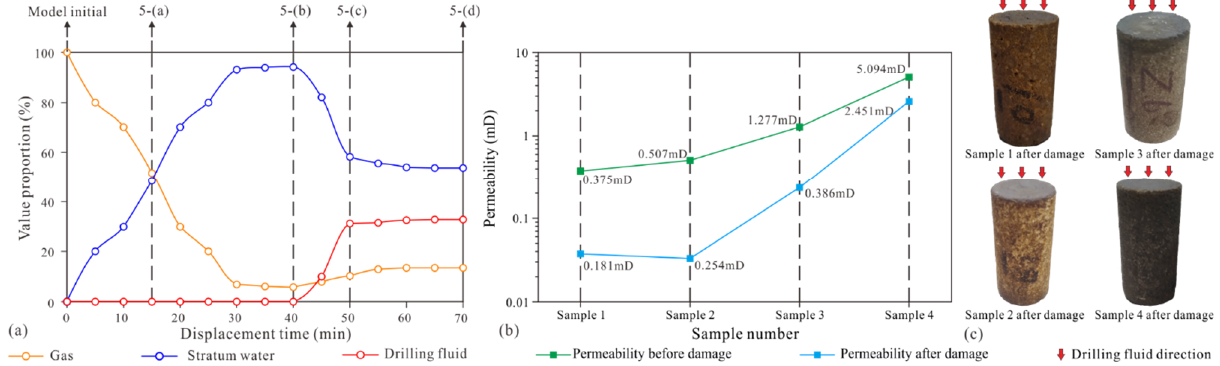
Figure 7. Quantitative analysis of formation damage by drilling fluid: ( a ) change in drilling fluid, gas, and water ratios with time for the microscopic model; ( b ) comparison of permeability of rock samples before and after damage by drilling fluid; ( c ) photos of rock samples after damage by drilling fluid through core flooding experiments.